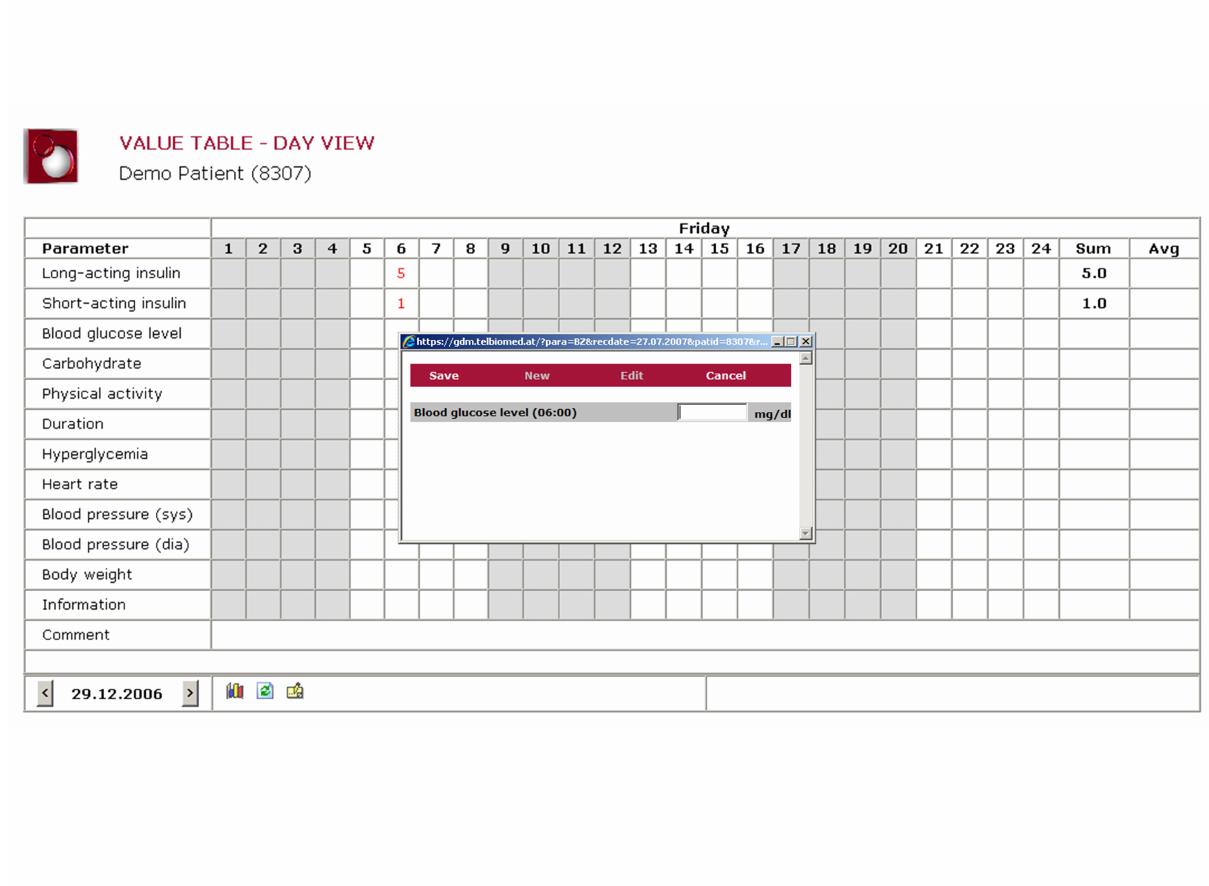
Figure 3. The diabetes data